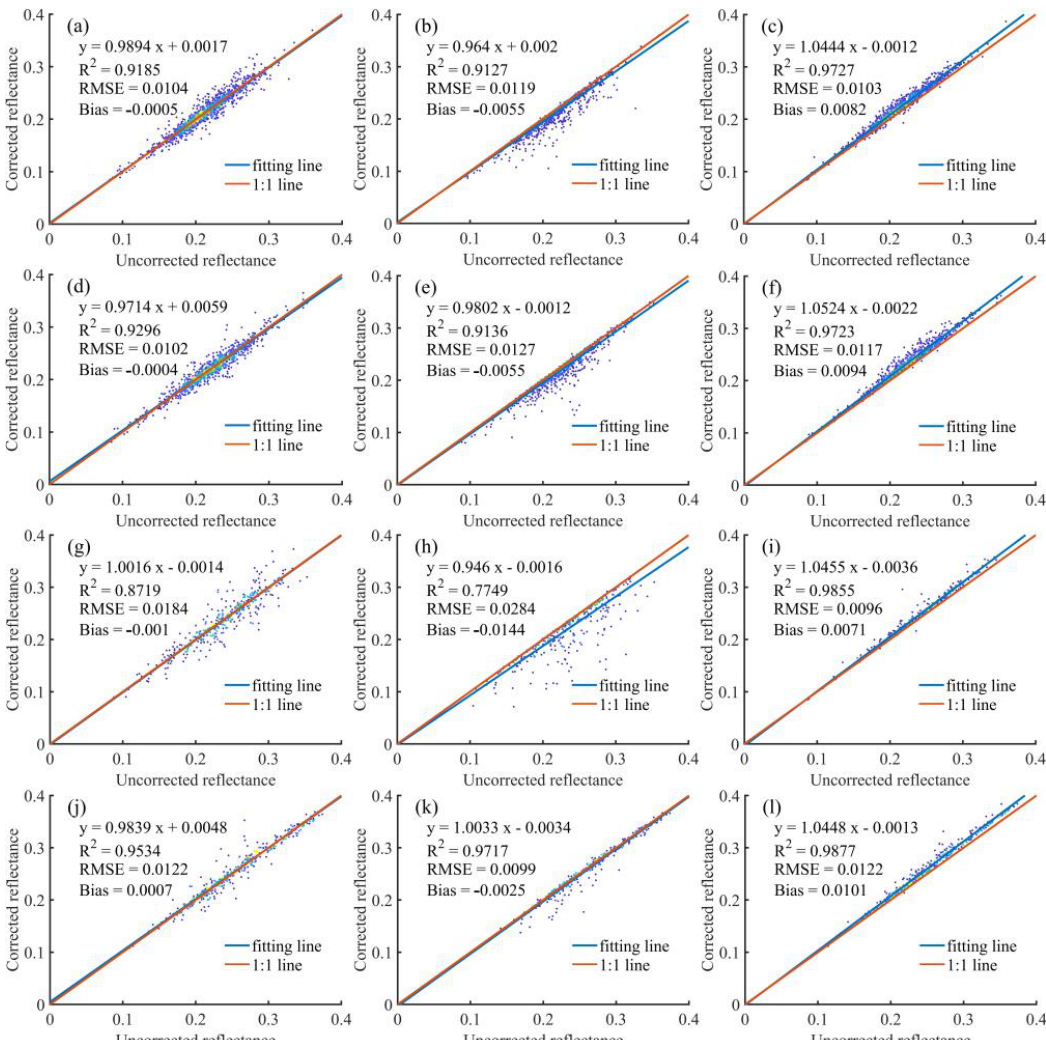
Figure 15. Density scatterplots between the corrected and original reflectance of herb ( a – c ), shrub ( d – f ), tree ( g – i ), and bare soil ( j – l ) over aspects perpendicular to the solar and viewing directions. ( a ) SCS+C, ( b ) Minnaert+SCS, ( c ) RA-TOC-CA; ( d ) SCS+C, ( e ) Minnaert+SCS, ( f ) RA-TOC-CA; ( g ) SCS+C, ( h ) Minnaert+SCS, ( i ) RA-TOC-CA; ( j ) SCS+C, ( k ) Minnaert+SCS, ( l )